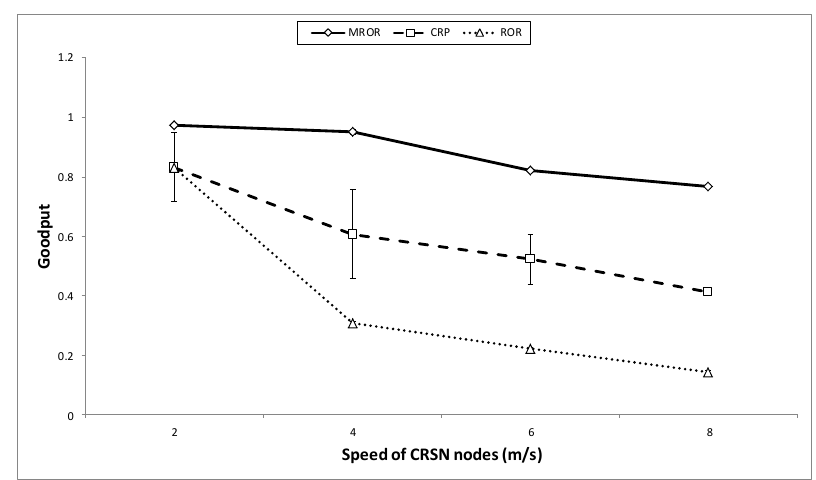
Figure 17. Goodput vs . speed of the mobile node.